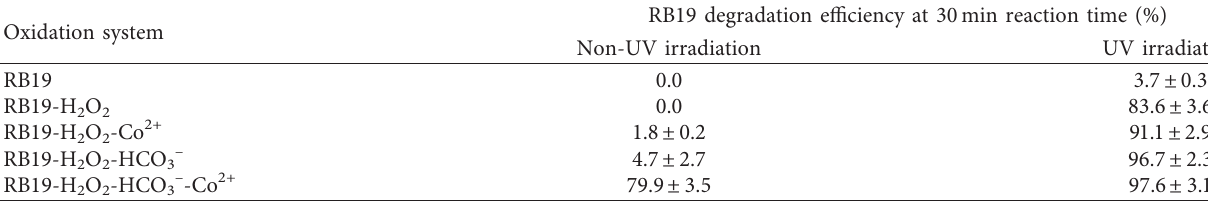
Table 3: The effect of UV irradiation on the RB19